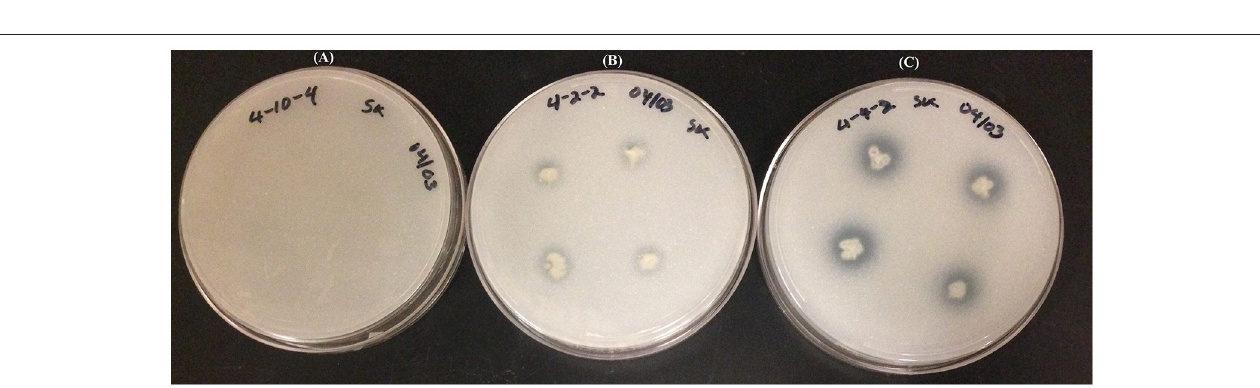
FIGURE 5 | Tricalcium phosphate (NBRIP) plates showing the phosphate solubilization gradient: Plate (A); no solubilization, Plate (B) ; moderate solubilization, and Plate (C) ; high solubilization.